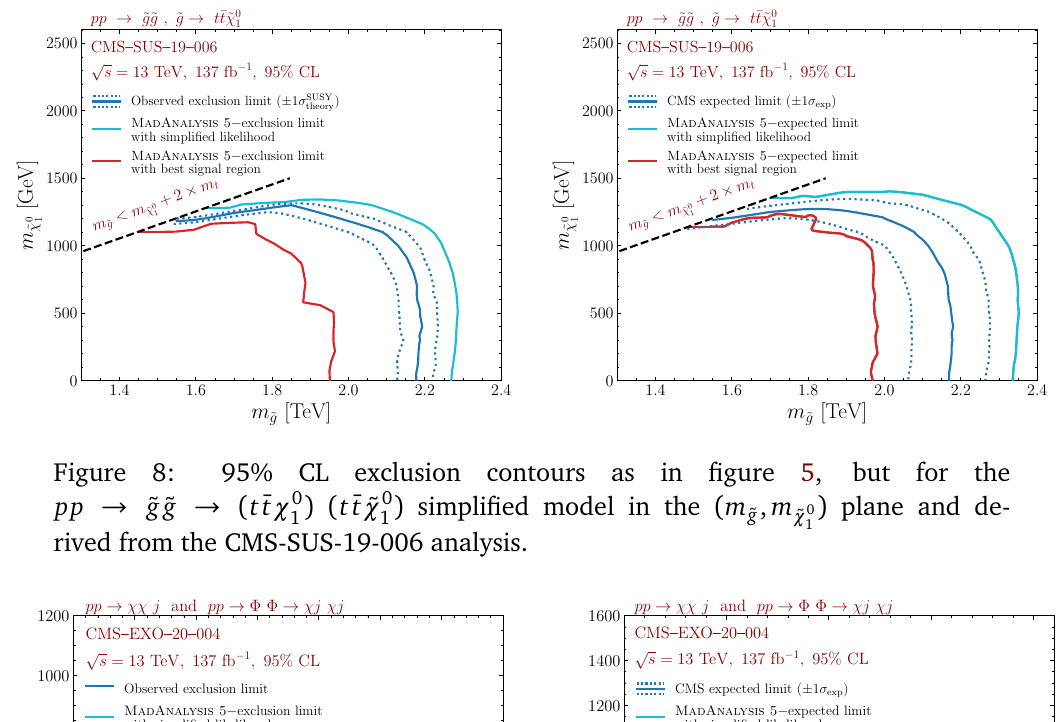
) plane and de- , m ˜ g ˜ χ 0 1